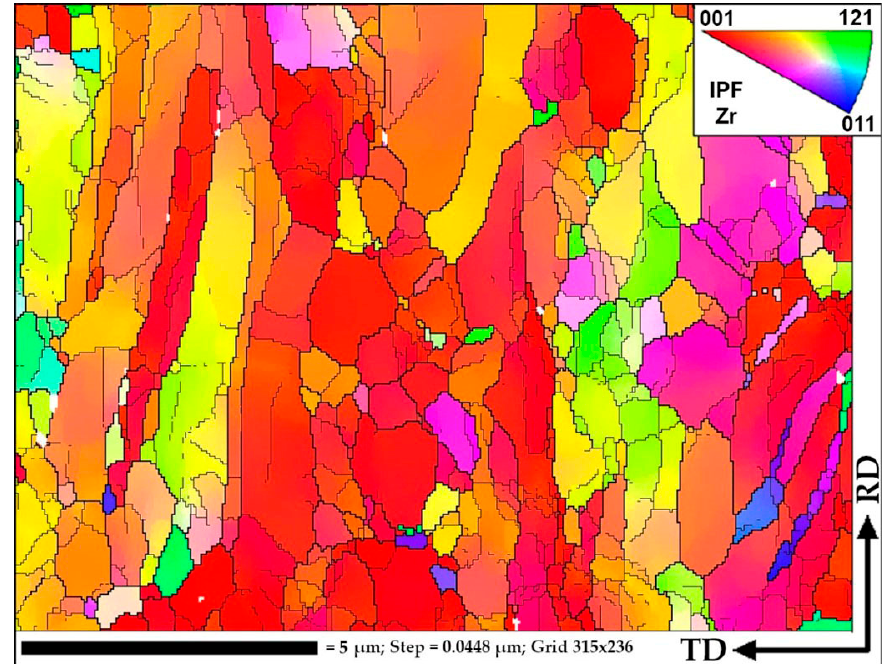
Figure 10. The final rolled sample cross-section structure EBSD study.